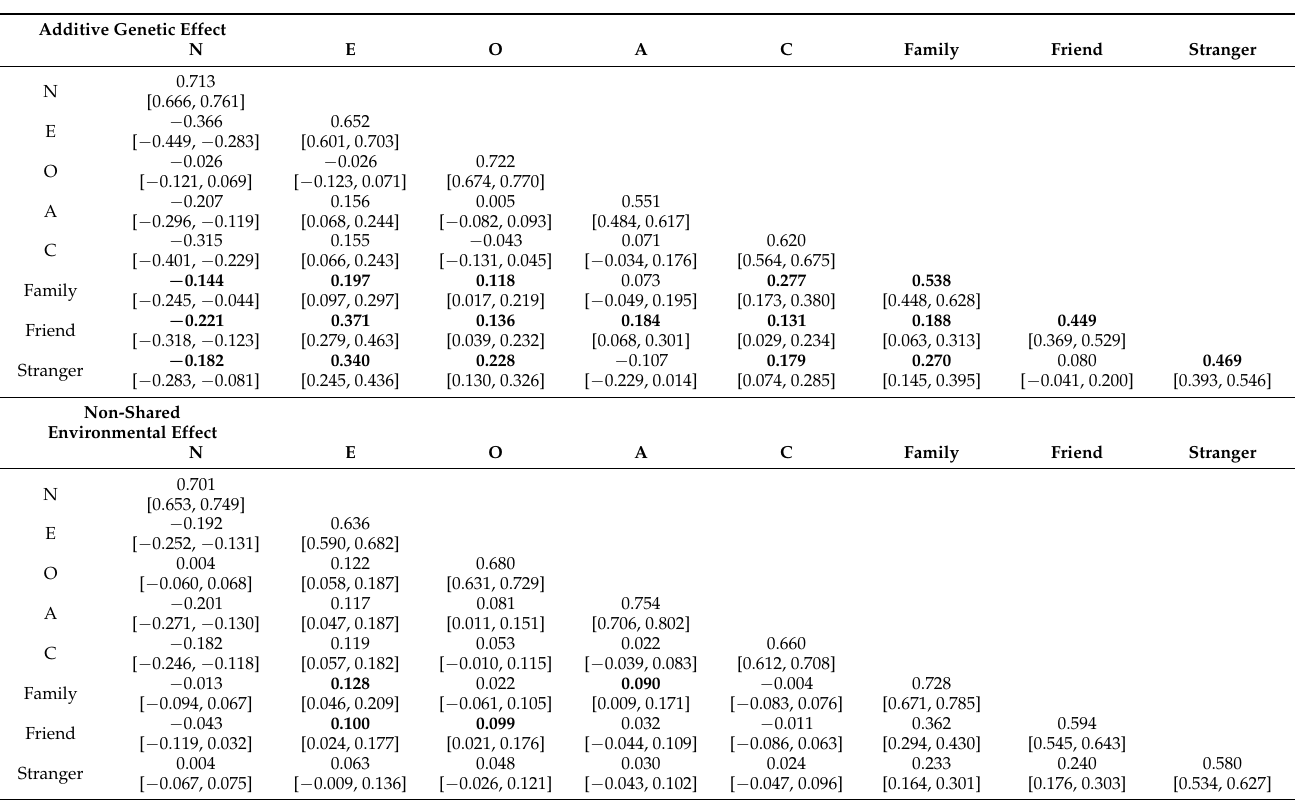
Table 4. Standardized estimates and their 95% confidence intervals (CIs) of Cholesky decomposition model on the big five personality dimensions and three recipient types of